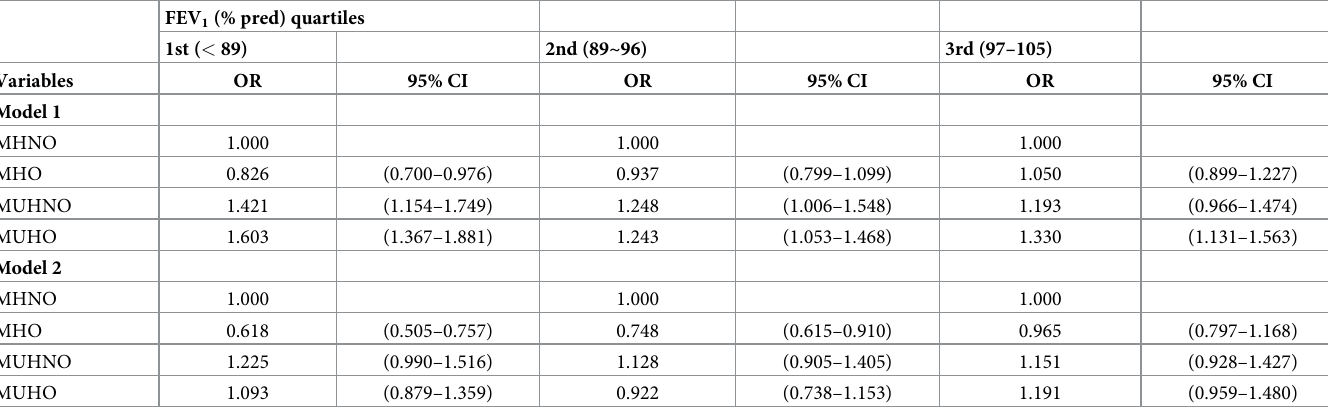
Table 5. Odds ratio for decreased lung function and metabolic health status according to quartiles of FEV 1 % of predicted value.